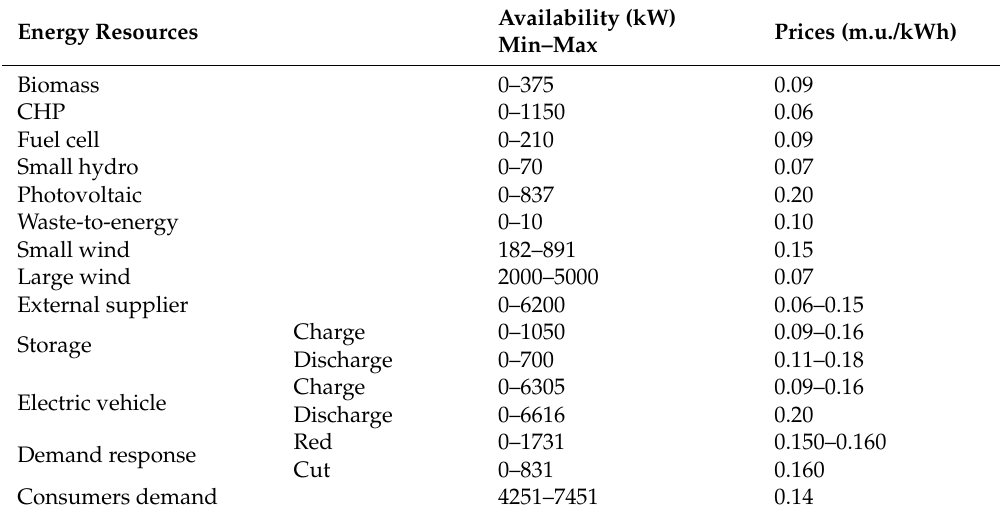
Table 1. Energy resources data.